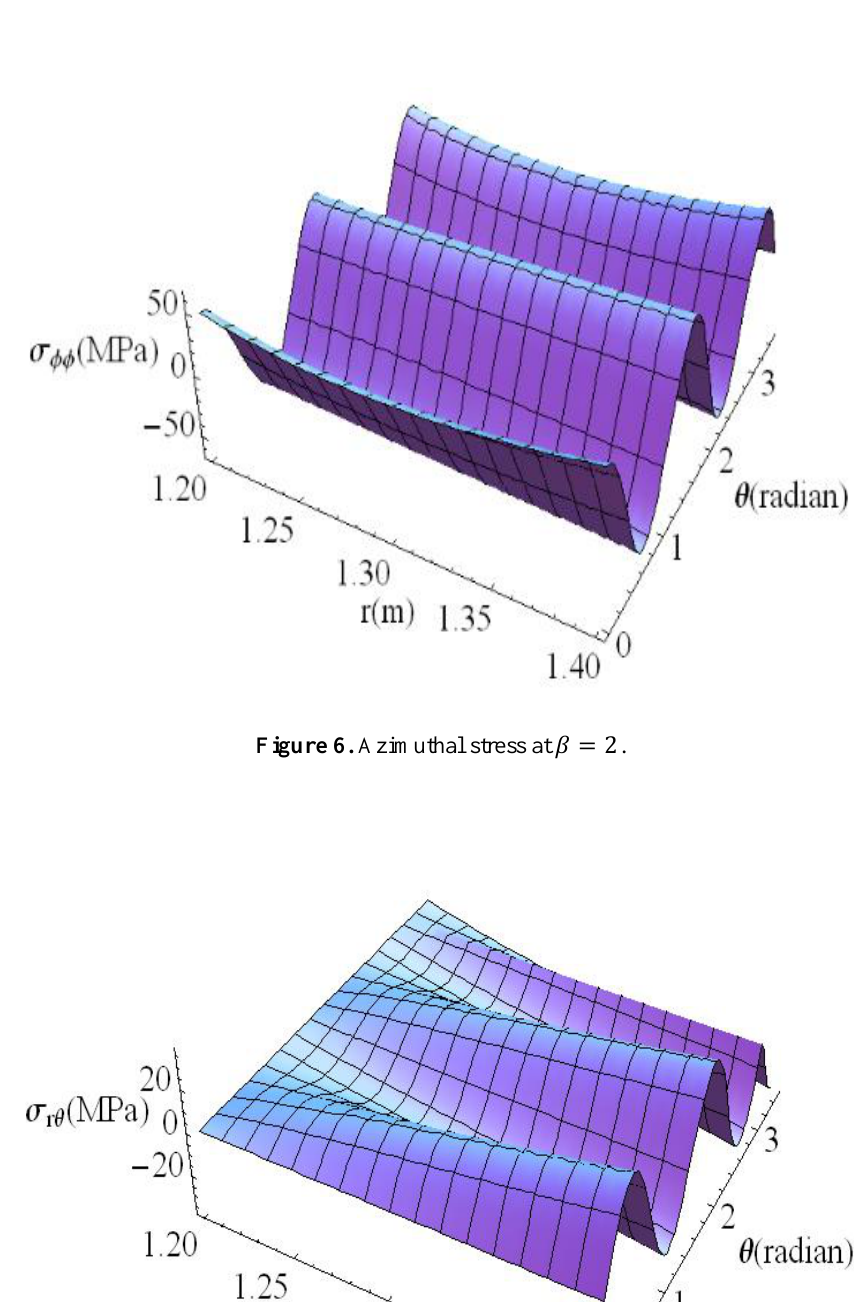
1124 | Vol. 6, No. 4, 2021